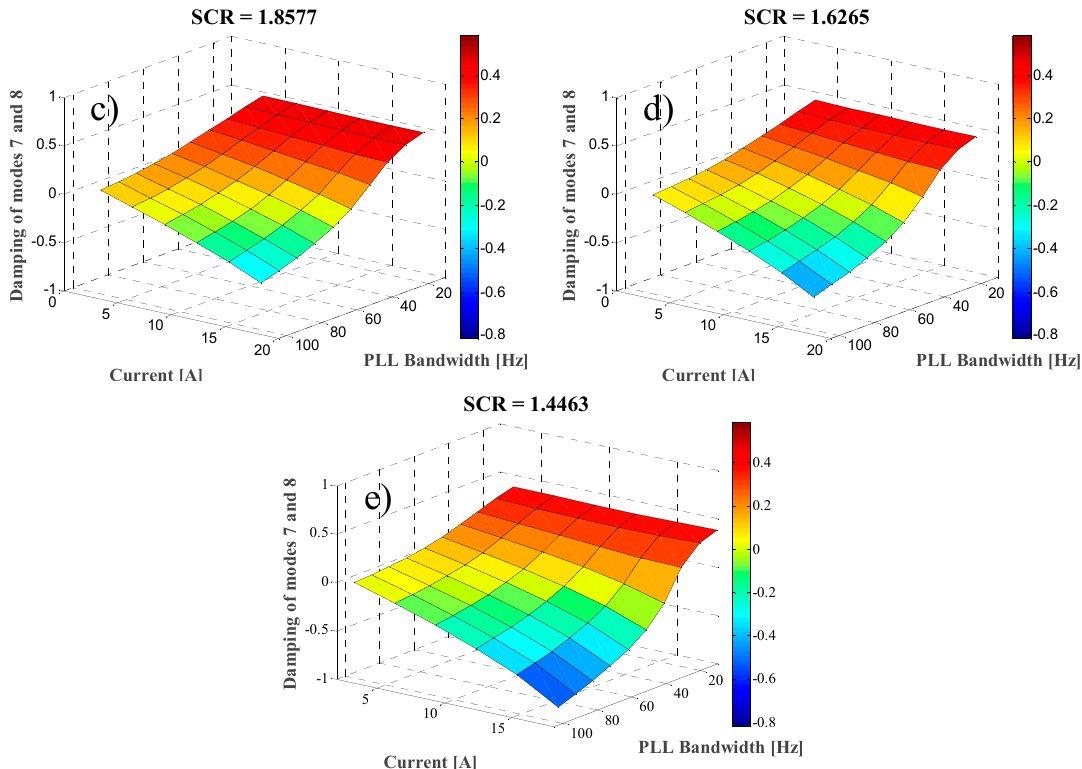
Figure 8. Damping of modes 7 and 8 of the proposed small signal model as a function of the PLL bandwidth and the active current injected by the converter into the weak grid, for the following short circuit ratios (SCR): ( a ) SCR = 2.5942; ( b ) SCR = 2.1652; ( c ) SCR = 1.8577; ( d ) SCR = 1.6265; ( e ) SCR = 1.4463.